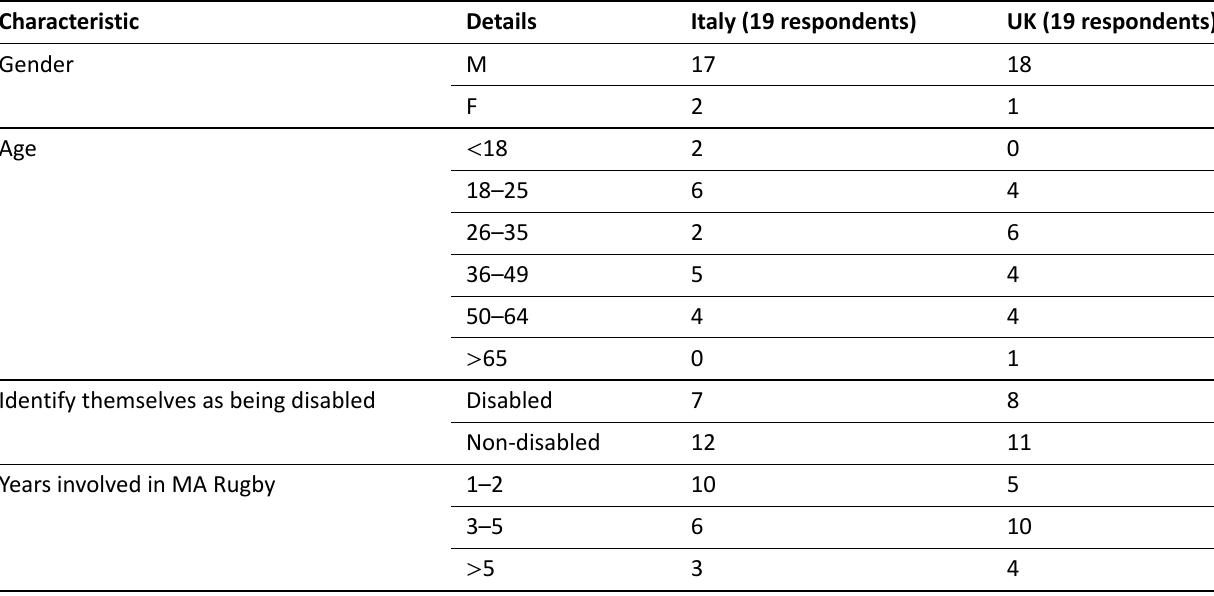
Table 1. Summary of online questionnaire respondent demographics.